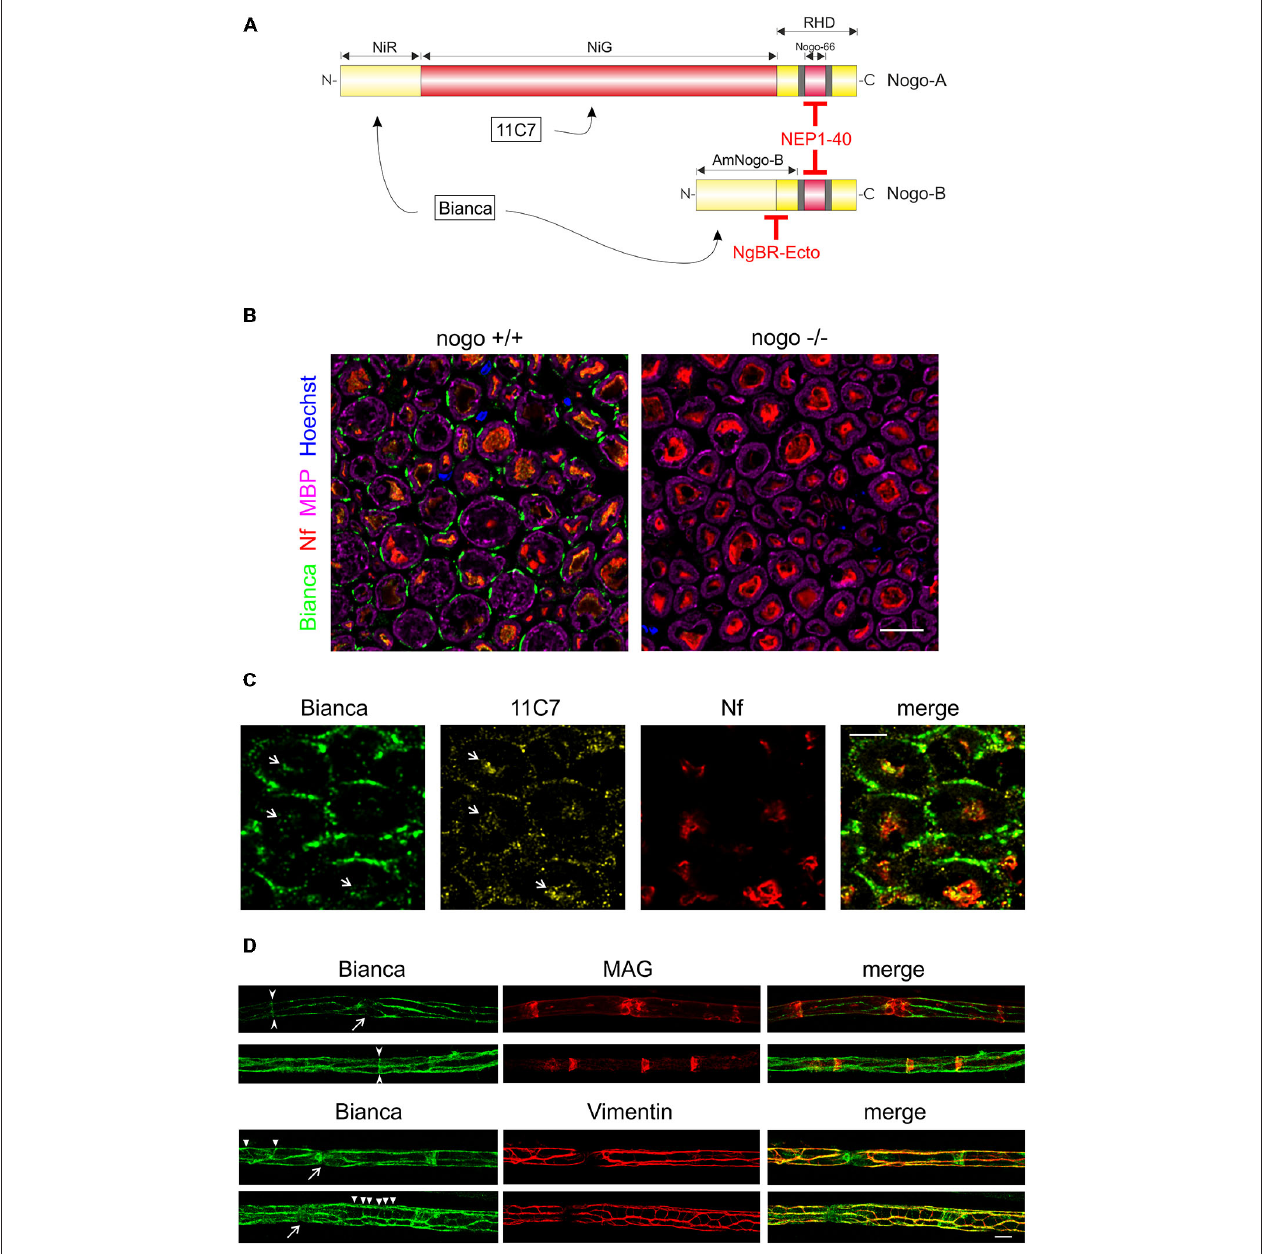
FIGURE 1 | Immunohistochemistry of Nogo-B in the sciatic nerve. (A) The two isoforms Nogo-A and Nogo-B differ considerably in size and function. A common feature is the C-terminal RHD which harbors not only an ER anchoring motif at the very C-terminus but also two hydrophobic sequence stretches (shaded in gray); they are believed to contribute to ER tubulation by inducing membrane curvature. Nogo-A is selectively recognized by the monoclonal 11C7 antibody while the epitope of the Bianca antiserum resides within the NIR domain that is shared by both isoforms. The NEP1–40 peptide is derived from and blocks the signaling activities of the Nogo-66 loop domain. The Nogo-B specific receptor NgBR, and recombinant NgBR-Ecto, bind to the AmNogo-B sequence stretch that is composed of parts of the NIR domain and RHD. (B) Immunolabeling of cross sections of the sciatic nerve of a wildtype and nogo-a/b knockout mouse. The external cytoplasmic compartment of Schwann cells is immunoreactive for Nogo. The myelin sheath that is visualized with myelin basic protein (MBP) is devoid of Nogo. Axons are revealed with a neurofilament antibody. Single confocal sections are shown. Scale bar is 10 µ m. (C) Immunolabeling of cross sections of the rat sciatic nerve with the Bianca antiserum and counter-staining with 11C7. Schwann cells are strongly positive for Bianca but not for 11C7 indicating that the majority of Bianca immunoreactivity is due to Nogo-B. In contrast, the Bianca immunoreactivity in axons seems to be due to Nogo-A as demonstrated by the 11C7 signal (white arrows). Scale bar is 5 µ m. A single confocal section is shown. (D) Immunolabeling of teased nerve fibers of the sciatic nerve of an adult wildtype mouse. There is prominent Nogo immunoreactivity in Cajal bands and, to a lesser extent, in Schmidt-Lanterman incisures (arrow heads) and transverse trabeculae (triangles) as revealed by MAG and Vimentin co-distribution. The Nogo staining typically extends into nodes of Ranvier (arrows). Single confocal sections are shown. Scale bar is 10 µ m.